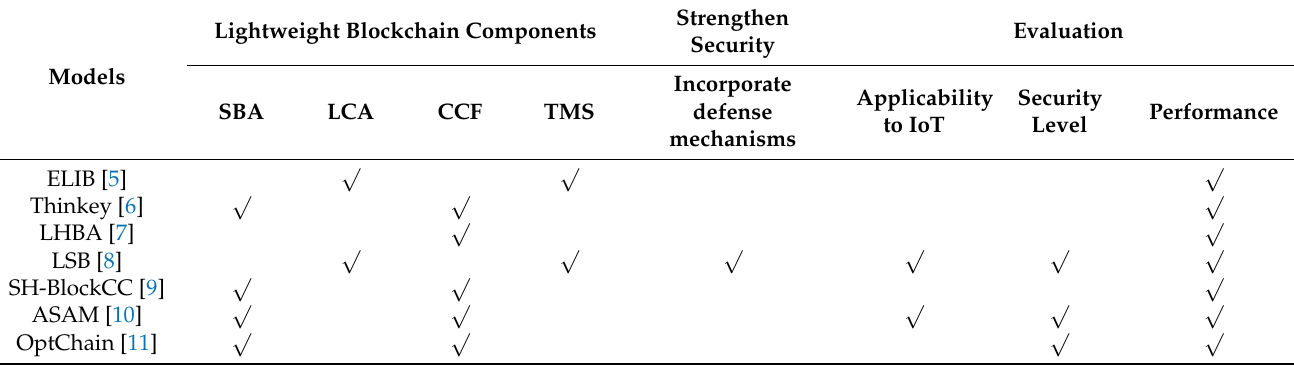
Table 2. Comparison between literature